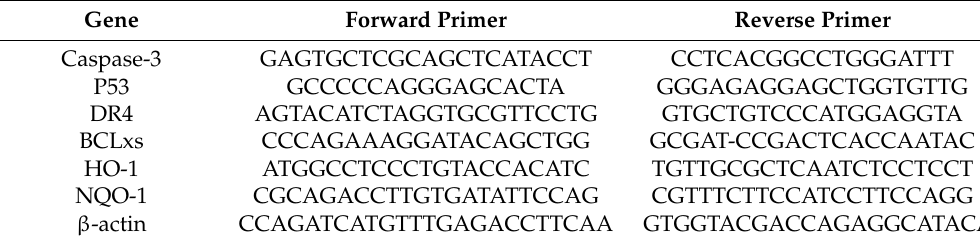
Table 1. Primers sequences used for RT-PCR